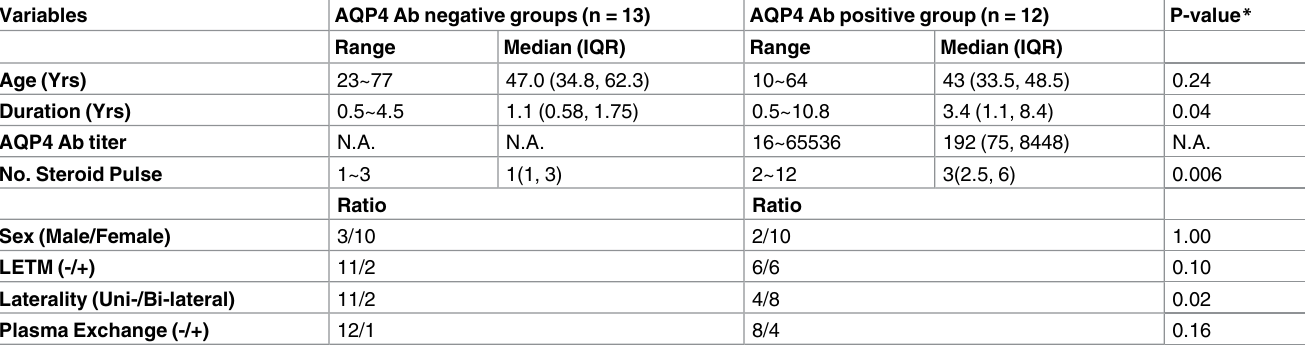
Table 1. Patient-based characteristics.